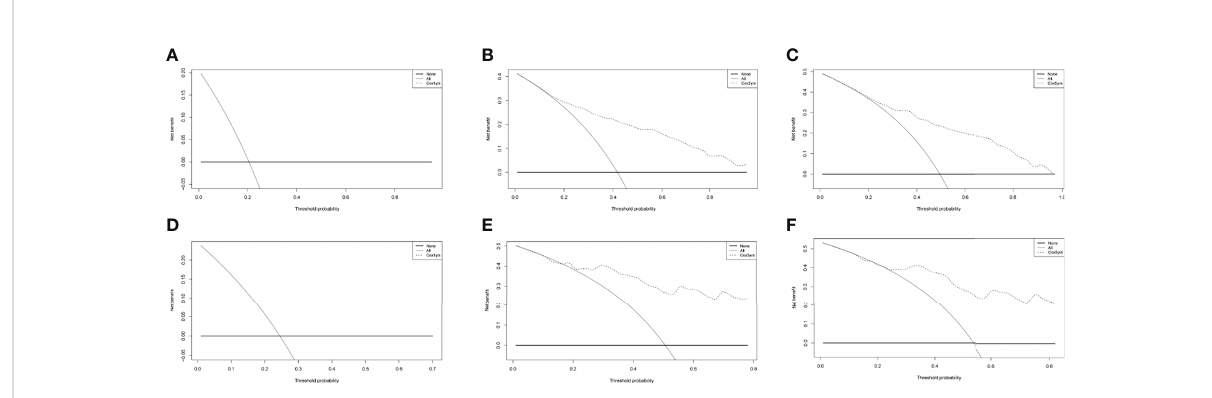
FIGURE 12 The DCA curves of the nomograms comparison for 1 year (A) , 3 year (B) , 5 year (C) in the training group, and for 1 year (D) , 3 year (E) , 5 year (F) in the validation group,